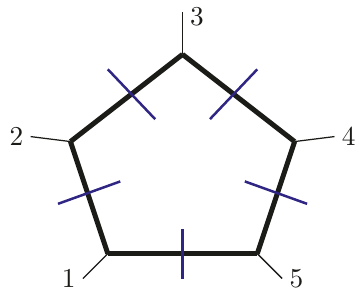
Figure 4 . The pentagon D -dimensional pole corresponds to the unique solution l 0 to the cut constraints